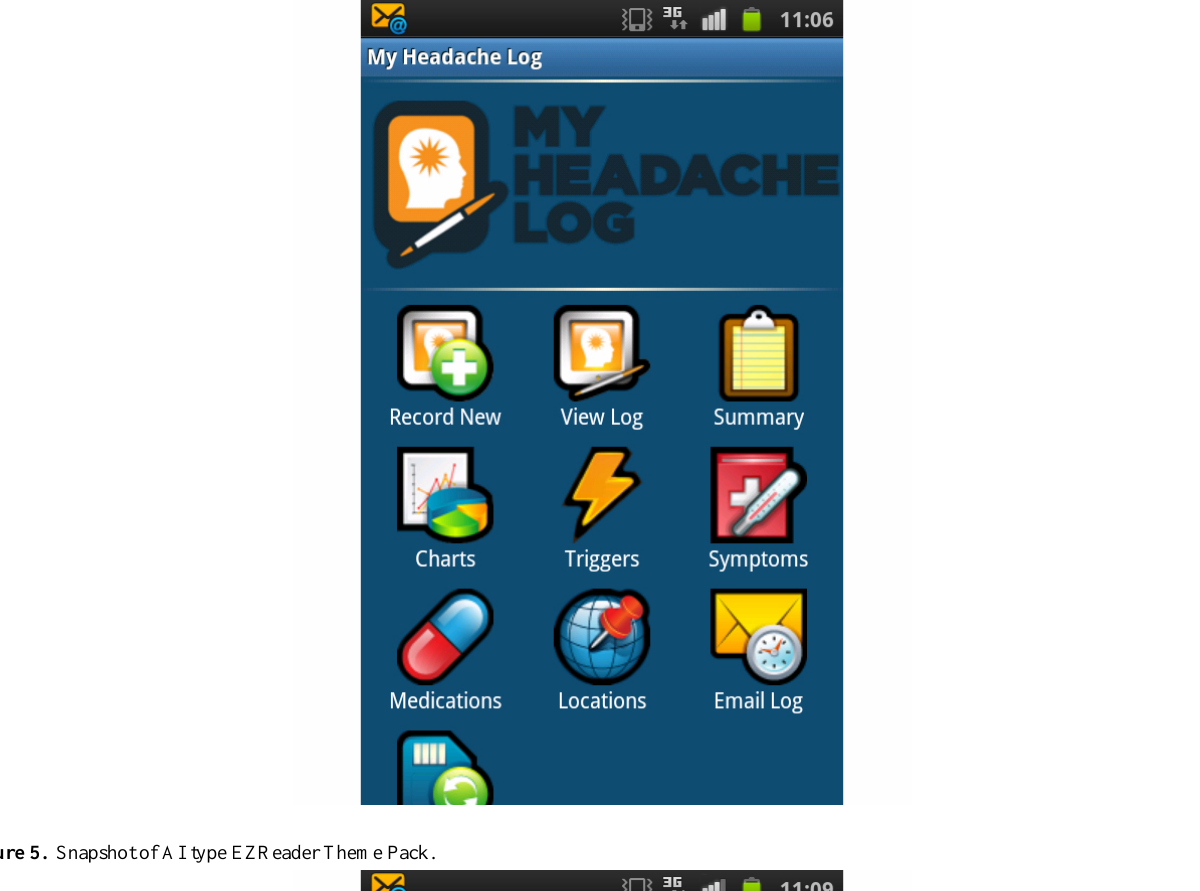
Figure 4. Snapshot of My Headache Log Pro.